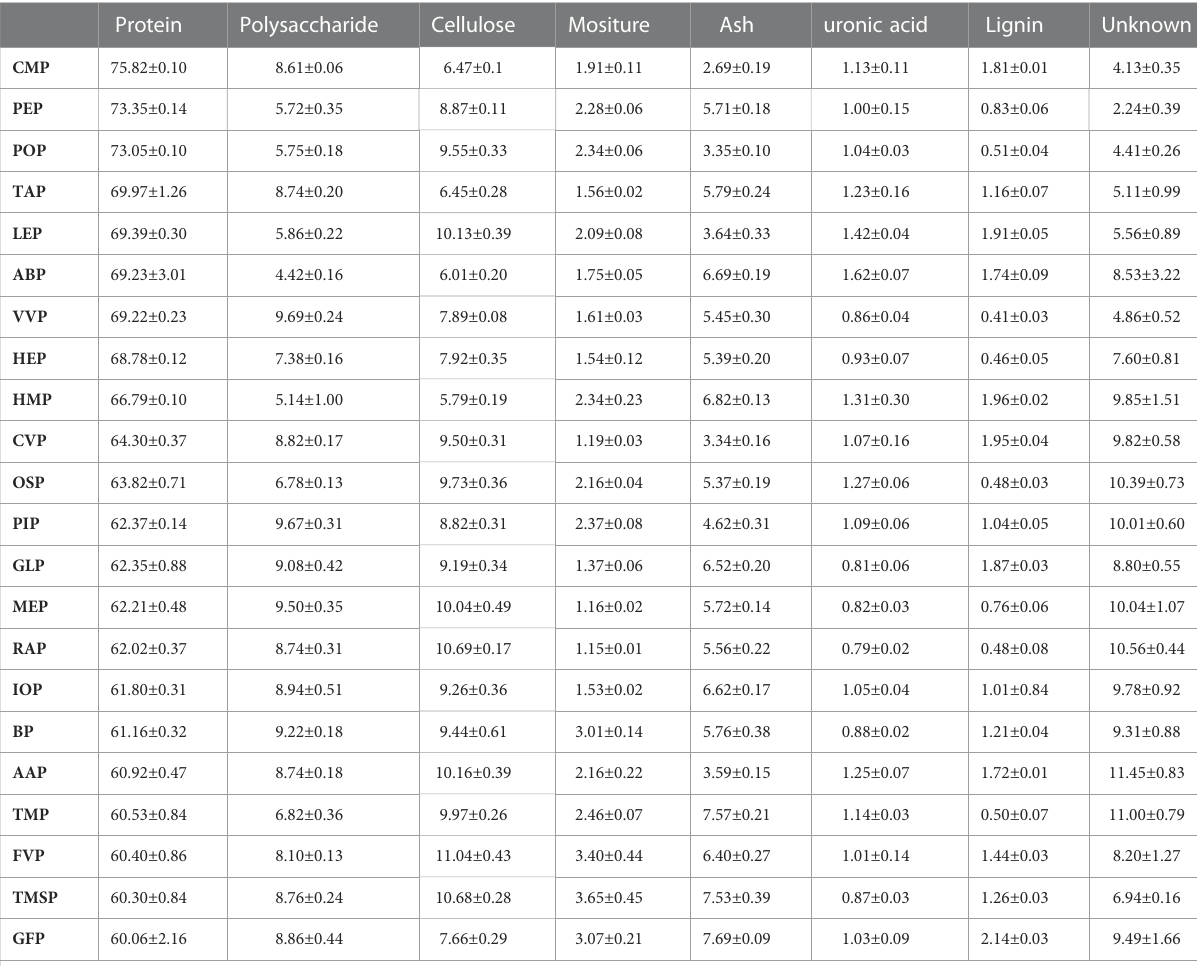
TABLE 2 Composition of proteins